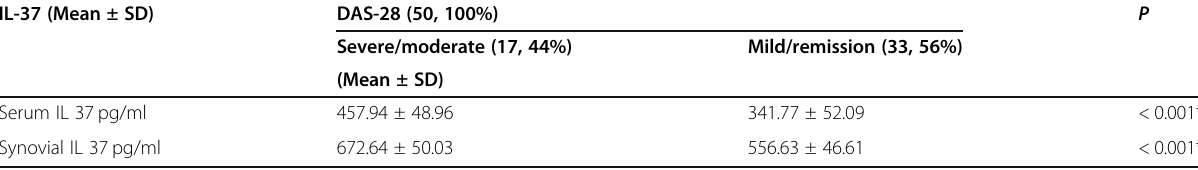
Table 4 Comparison between the mean serum and synovial IL-37 levels in the RA group in respect to the disease activity (DAS-28) IL-37 (Mean ±